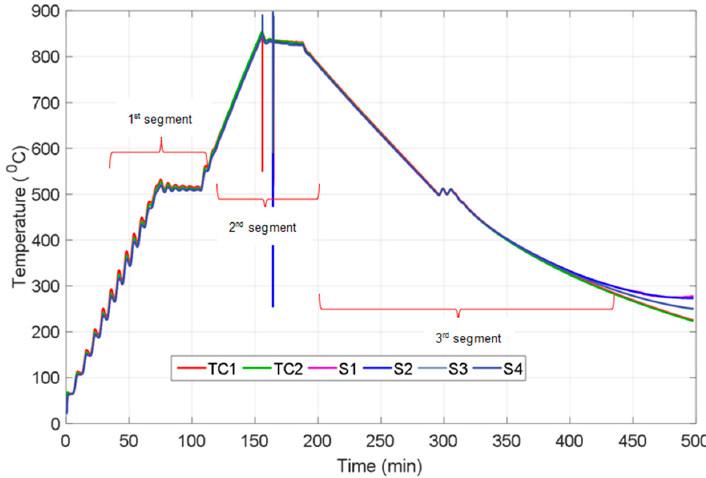
Figure 3. Temperature profile of two thermocouples and four sensing point of the sensor.